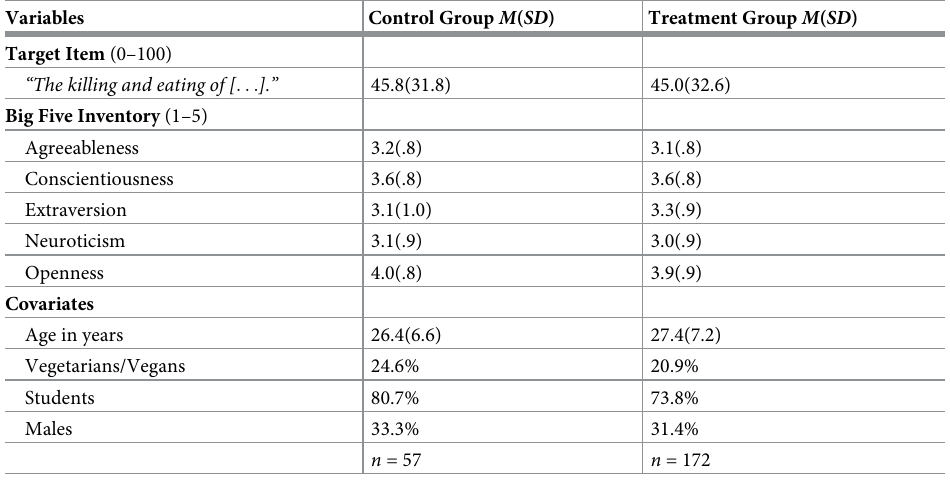
Table 1. Descriptive statistics (control vs. treatment group, t 1